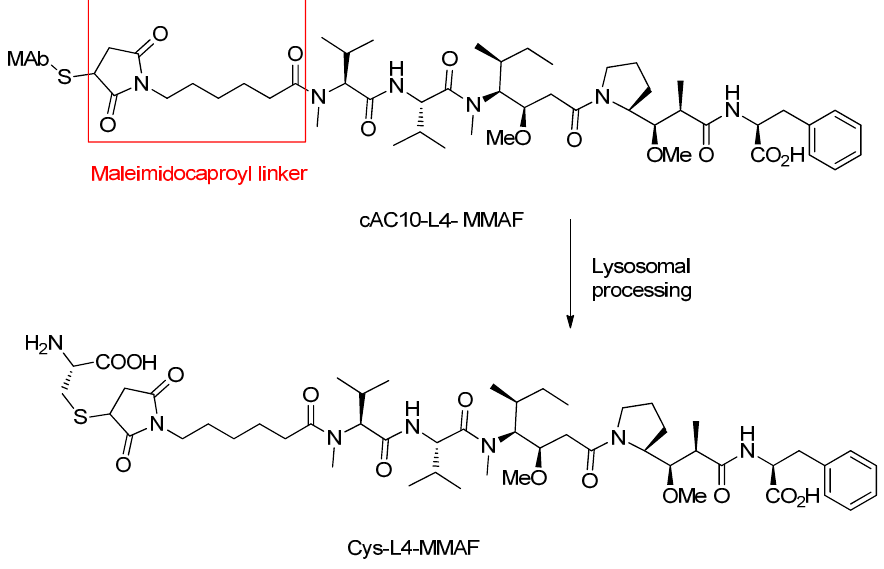
Figure 6. The structural formula of the cAC10-L4-MMAFand the supposed cleavage mechanism after internalization into the lysosome. Adapted from reference [43,50].